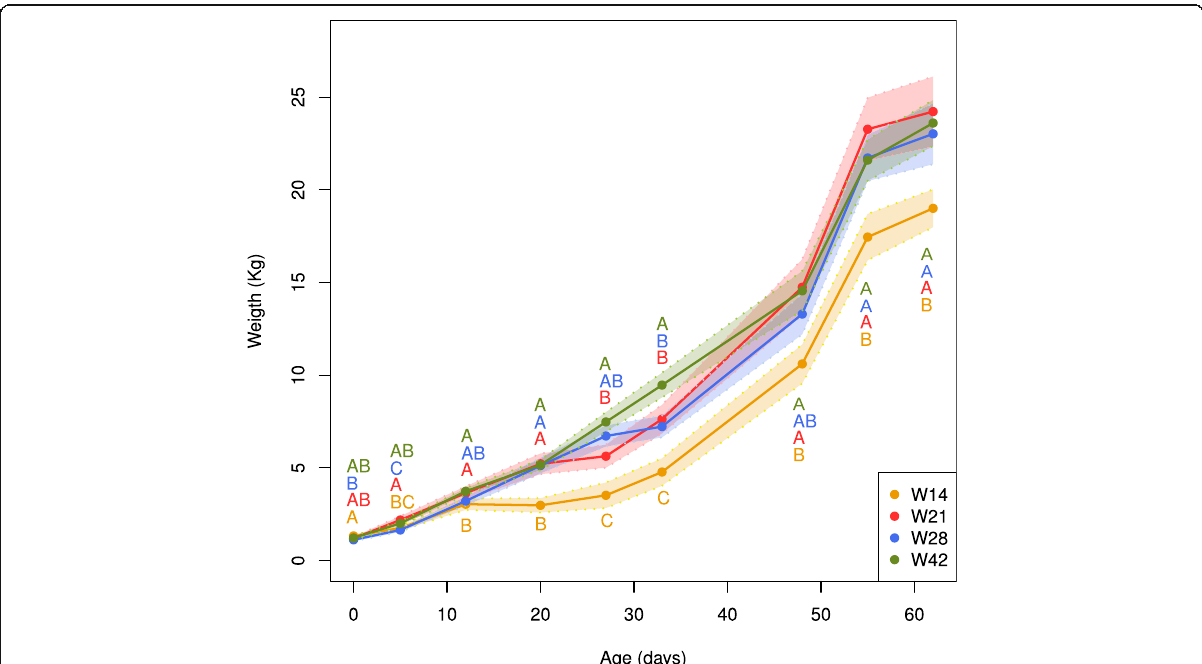
Fig. 1 Growth curves for piglets weaned at 14 days of age (W14), 21 days of age (W21), 28 days of age (W28), and 42 days of age (W42). The solid and dashed lines show each group ’ s mean and standard deviation, respectively. The initial sample sizes for each group were as follows: W14: 10 animals, W21: 12 animals, W28: 12 animals, and W42: 10 animals. The samples sizes for each group after weaning were as follows: W14: 4 animals, W21: 6 animals, W28: 6 animals, and W42: 5 animals. Any statistical differences between groups are indicated by different letters in each time point, and further details can be found in Additional file 5: Table